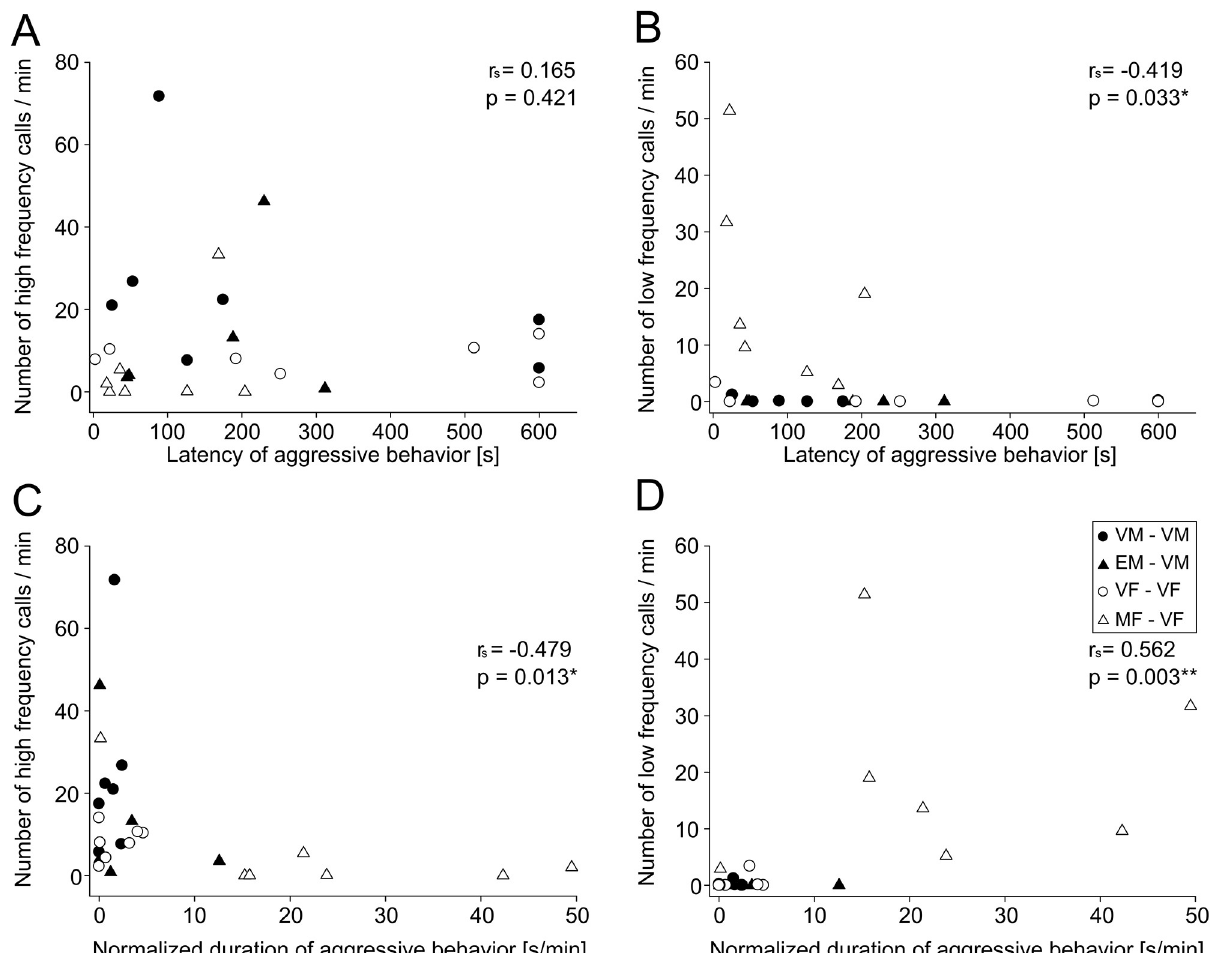
Fig 7. Relationship between two types of calls and aggressive behaviors. (A) Distributions of latency of aggressive behavior and rate of high- frequency vocalizations. (B) Distributions of latency of aggressive behavior and rate of low-frequency vocalizations. (C) Distributions of duration of aggressive behavior and rate of high-frequency vocalizations. (D) Distributions of duration of aggressive behavior and rate of low-frequency vocalizations. Each symbol represents vocalizations from a single test ( ● , virgin male; ▲ , experienced male; ● , virgin female; ▲ , multiparous female). � represents p < 0.05. �� represents p <